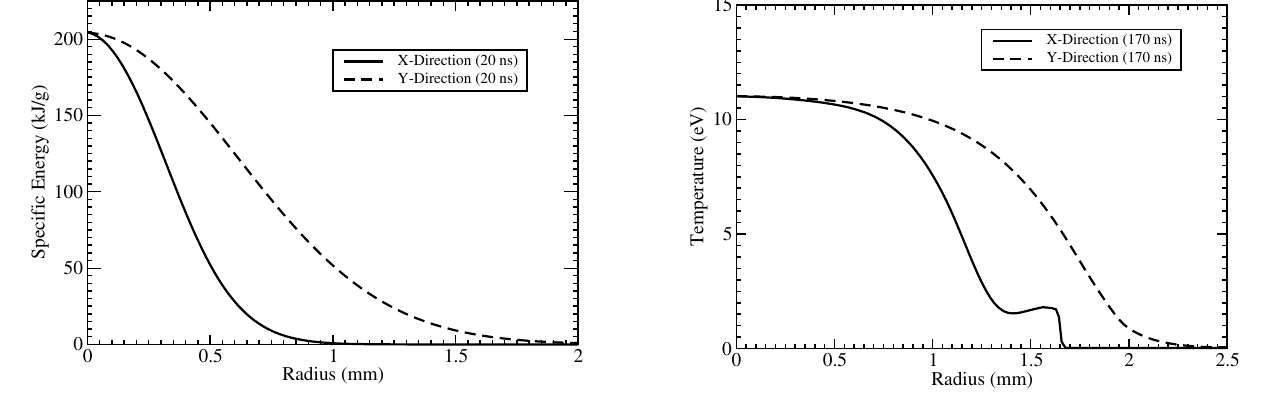
FIG. 23. Temperature corresponding to the case presented in (cid:3) 0 : 3 mm Fig. x